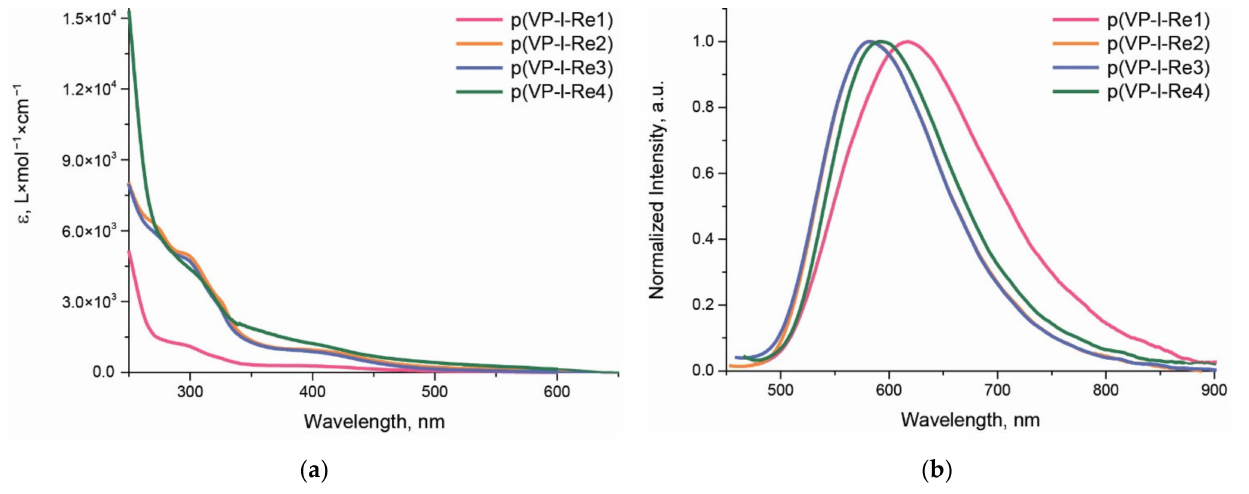
Figure 4. ( a ) Electronic absorption spectra of p(VP-l-Re) and ( b ) normalized emission spectra of